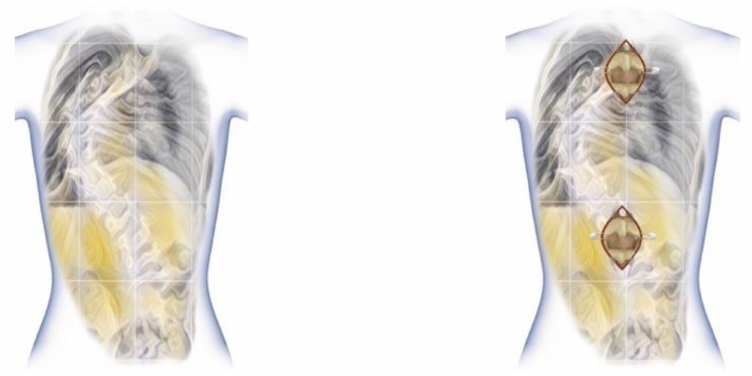
Figure 5. Less-invasive approach for upper and lower